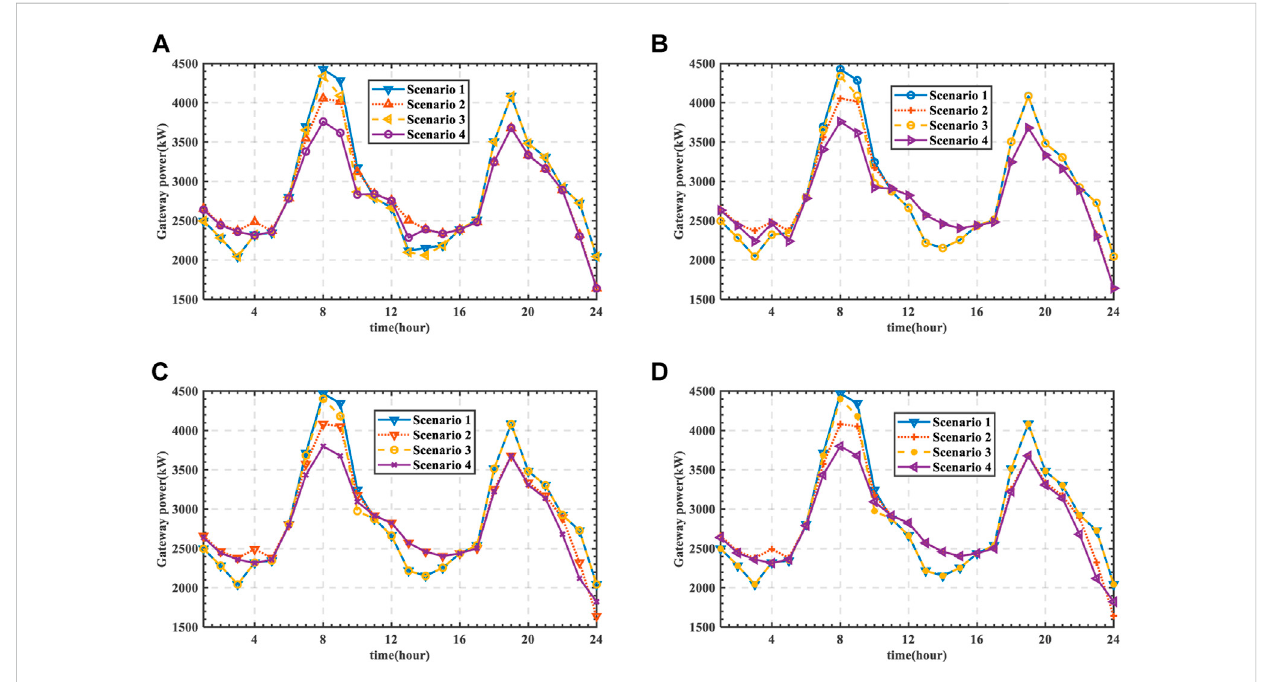
FIGURE 10 Gateway power of DN for the shortest travel time path.